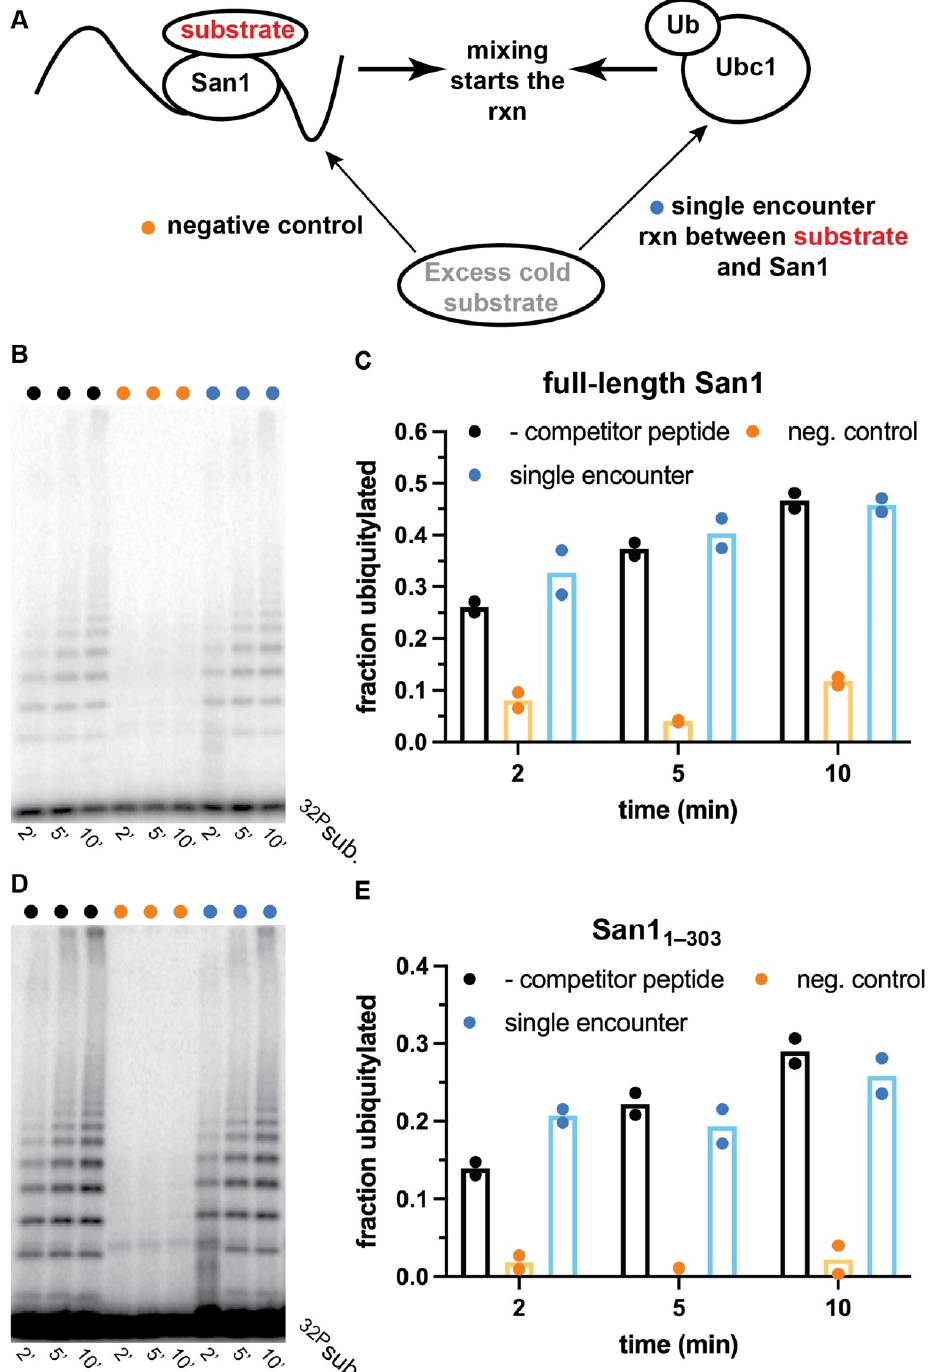
Figure 4. Radiolabeled peptide substrate dissociation from San1 is negligible during single-encounter ubiquitylation reactions. ( A ) Schematic showing how ubiquitylation reactions that are single-encounter for San1 and substrate are assembled. ( B ) Representative autoradiogram of ubiquitylation reactions between radiolabeled peptide substrate and full-length San1. Lanes 1–3 represent time points for a ubiquitylation reaction without excess cold peptide (black dots). Lanes 4–6 represent a negative control reaction where excess cold peptide is first incubated with San1 prior to the addition of radiolabeled substrate (orange dots), and lanes 7–9 represent the results for the single-encounter reaction (blue dots). ( C ) graphical representation of the results in ( B ). ( D ) same as ( B ) except with San1 1–303 . ( E ) same as ( C ), except with San1 1–303 . The results show duplicate data points from technical experimental